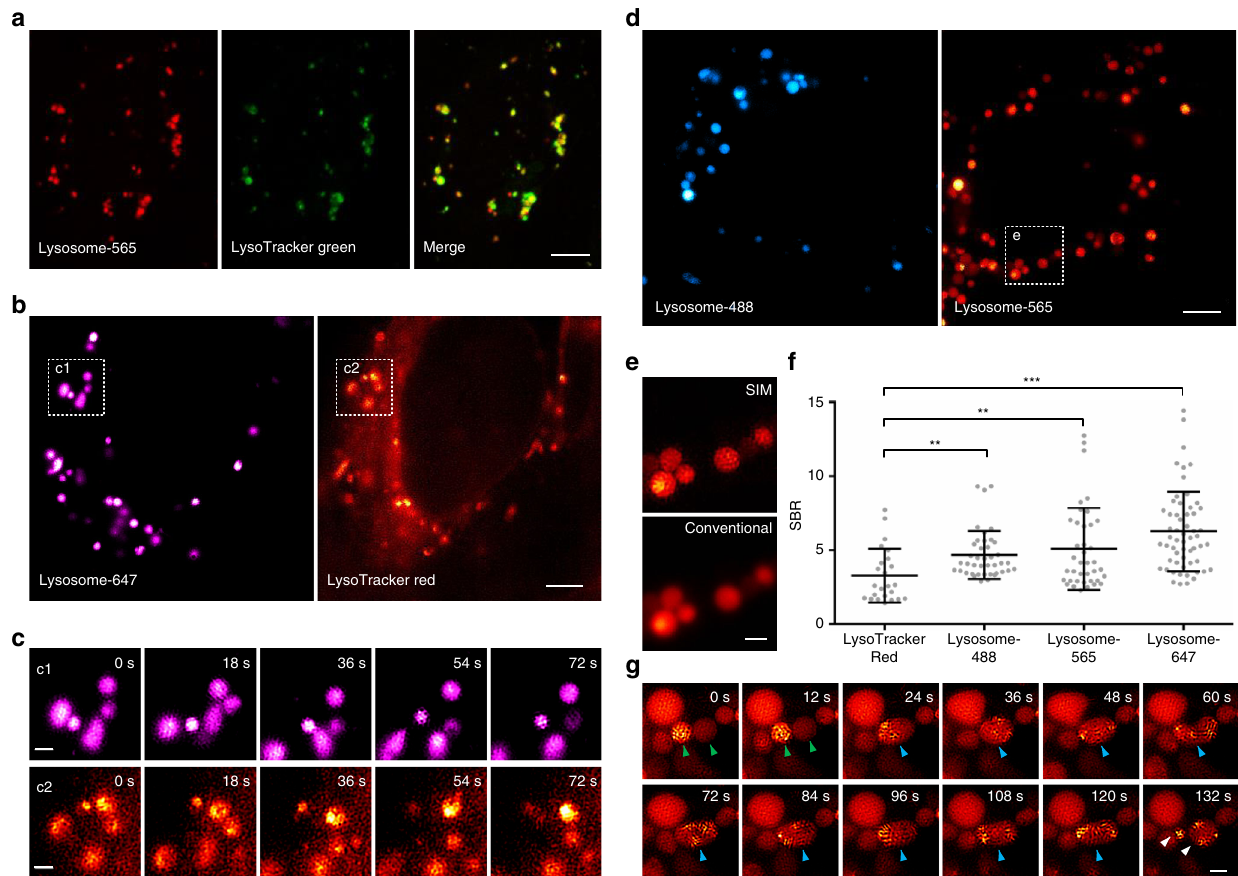
Fig. 1 Characterization of the lysosomal probes in live cells. a A co-localization study employing LysoTracker Green as the standard lysosomal marker. Live U2OS cells were simultaneously stained with Lysosome-565 (red) and LysoTracker Green (green, 50 nM) for 30 min and imaged by confocal microscopy. b Dual-color SIM images of lysosomes in live U2OS cells stained with both Lysosome-647 (magenta) and LysoTracker Red (red, 50 nM). c Enlarged time- lapse images from the boxed regions shown in b . d SIM images of live U2OS cells after incubation with Lysosome-488 (blue) or Lysosome-565 (red). e Enlarged super-resolution SIM (upper panel) and diffraction-limited (lower panel) images from the boxed region shown in d . f Average signal (lysosomes) to background (cytosol) ratios (SBR) of LysoTracker Red (SBR from n = 24 areas), Lysosome-488 (SBR from n = 41 areas), Lysosome-565 (SBR from n = 40 areas), and Lysosome-647 (SBR from n = 58 areas) in three SIM images (mean ± s.d.; ** P < 0.01, *** P < 0.0001, two-tailed t-test; statistics were performed using SPSS 19.0 software package (IBM Co.)). g Time-lapse images illustrating the process of lysosomal fi ssion-fusion. Each SIM frame was acquired over 270 ms (i.e., a raw data exposure time of 30 ms). For the time-lapse images, consecutive SIM frames spaced at 6-s intervals were obtained; representative images of consecutive SIM frames are displayed (more frames are shown in Supplementary Movie 1). Scale bars, a 5 μ m, b , d 4 μ m, and c , e , g 1 μ